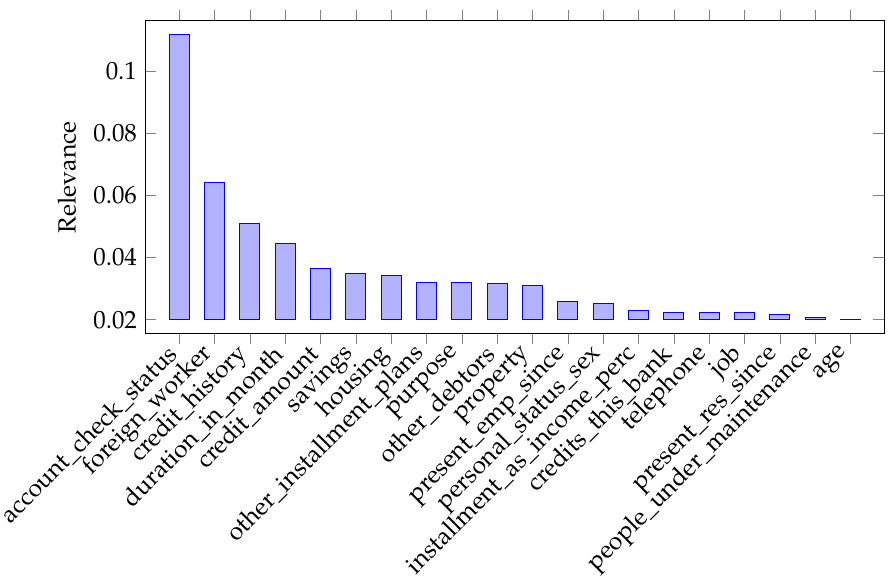
Figure 4. Results of the gain ratio for the German Credit dataset.